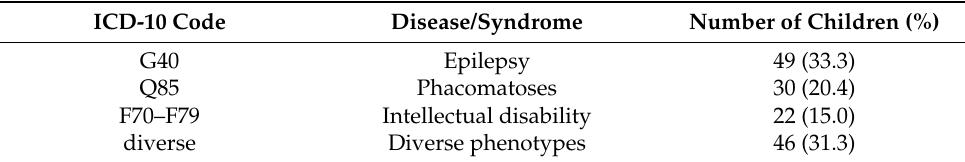
Table 1. Main diagnosis of the Paediatric Patients ( n = 147). ICD-10